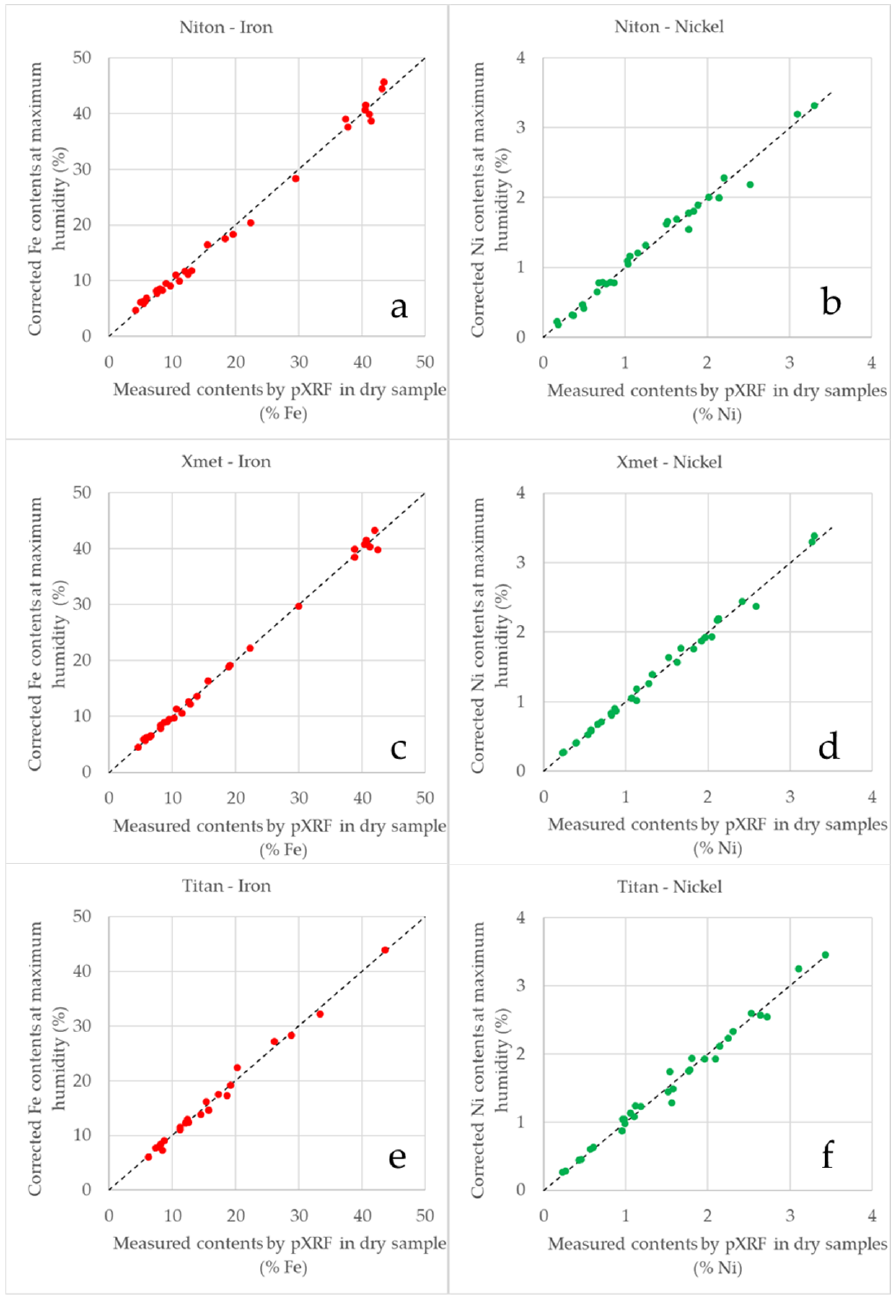
Figure 13. The relationship between corrected Ni and Fe concentrations measured at maximum humidity and concentrations on dry samples: ( a , b ) Niton, ( c , d ) Xmet and ( e , f ) Titan. For laboratory samples, the particle size is less than 75 µ m and sample wetting is well controlled. It is questionable whether this linear relationship is still valid for a direct measurement on the mining front. This method will be usable anyway if the sample is finely